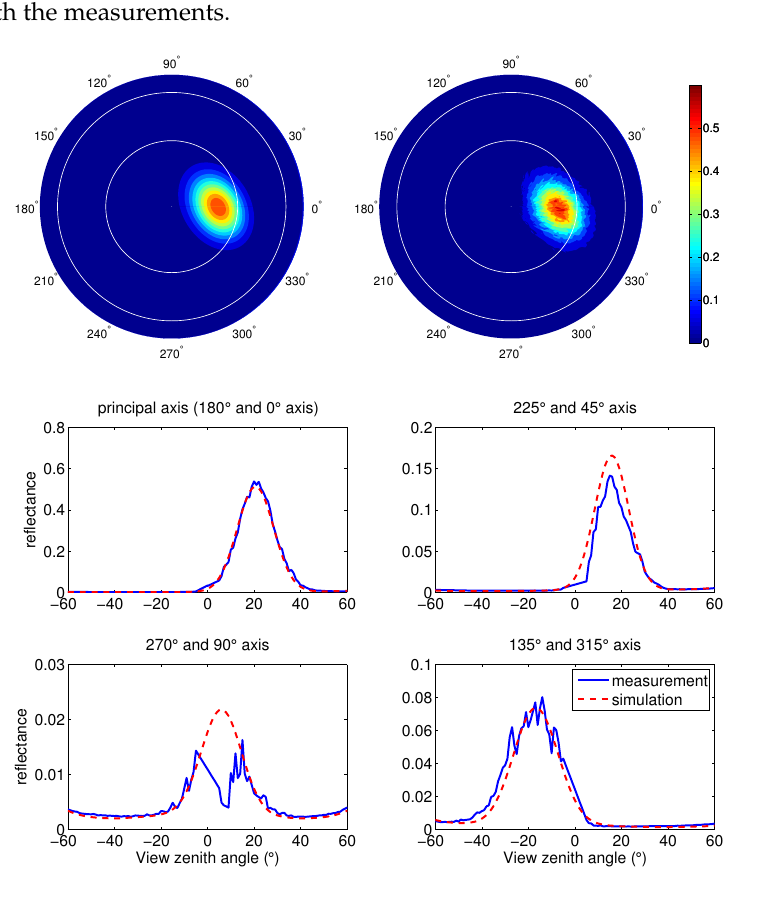
Figure 3. Comparison between model-simulated and measured reflectances. The measurements are in solid blue and the simulations in dashed red lines. The dip in the measured reflectance in the lower left panel is due to aircraft shadowing. [Reproduced from Figures 1a and 2a of